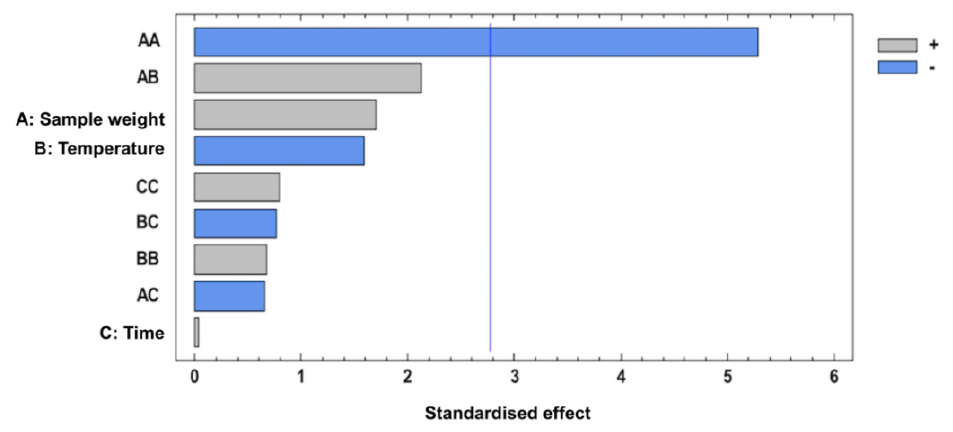
Figure 2. Pareto chart of the standardized effects of a BBD for the total obtained response area.